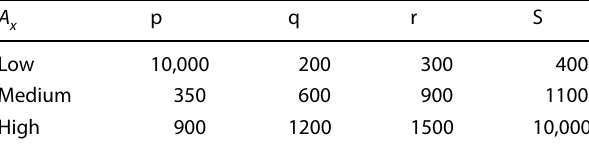
Table 5 Boundary points for wear amount membership